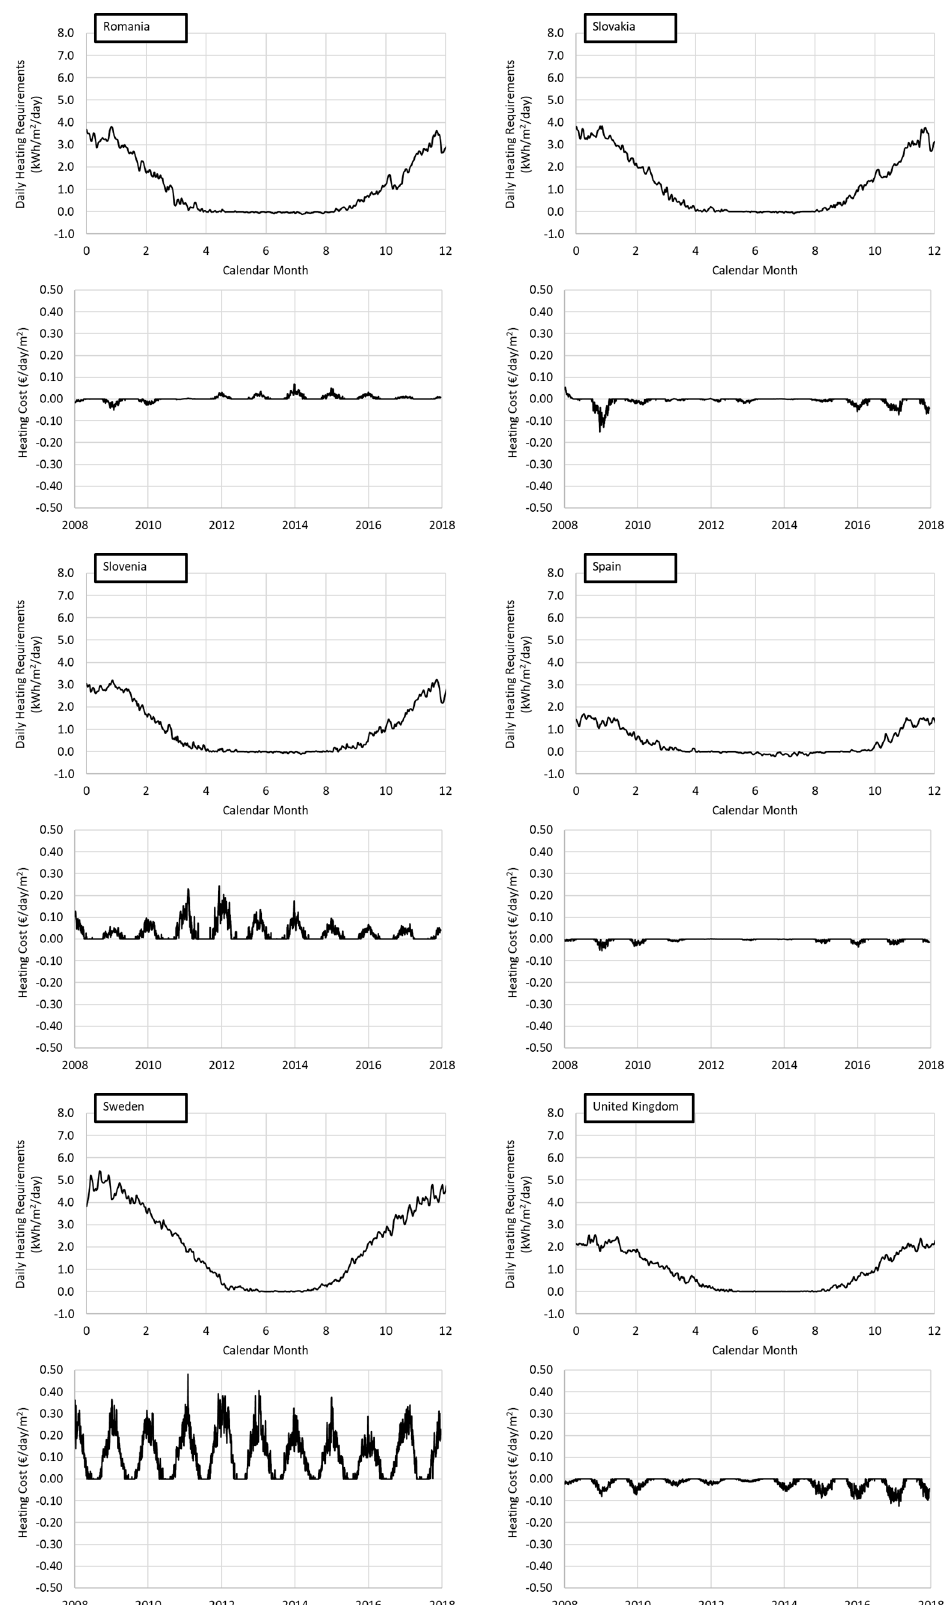
Figure A2. Seasonal representation of energy requirements and variation of energy cost in European countries during 2008–2018.